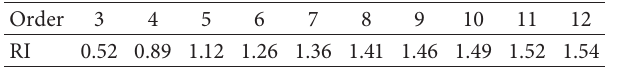
Table 5: RI value